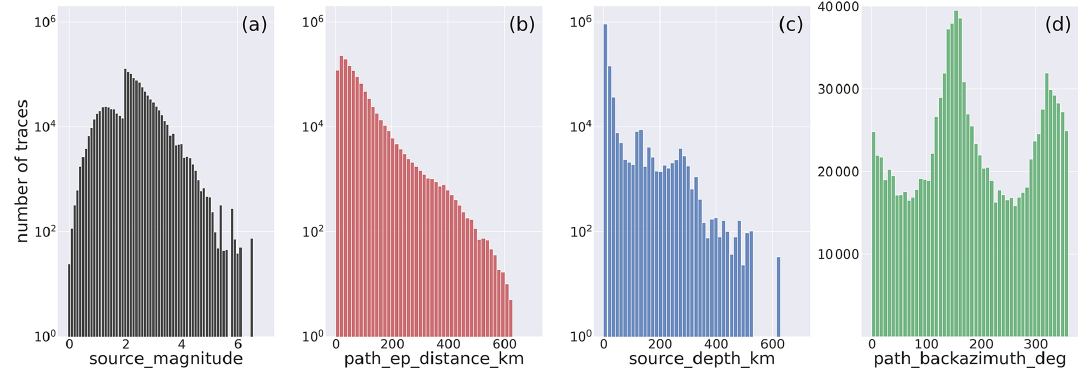
Figure 3. Histograms of the distribution of the trace records composing the dataset according to magnitude (a) , epicentral distances (b) , earthquake depth (c) , and back azimuth (d) . The labels of the horizontal axis are assigned using the metadata names listed in Table